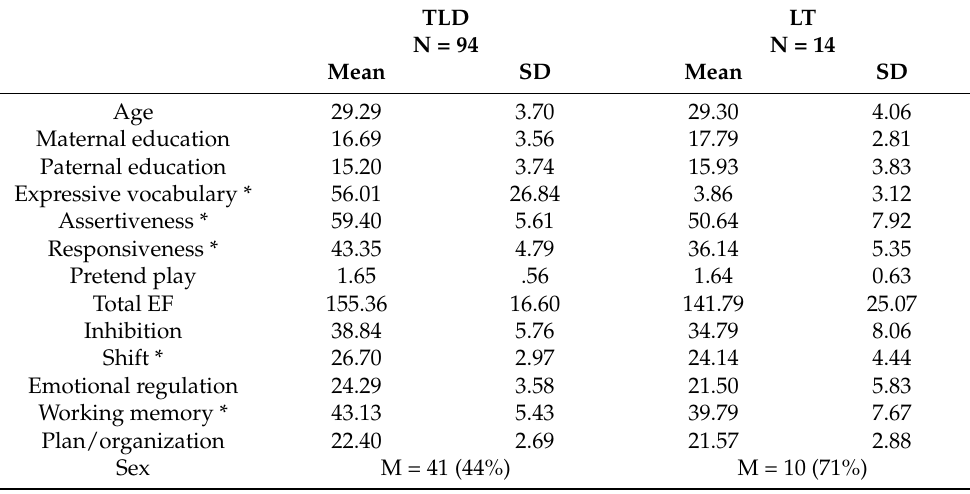
Table 2. Characteristics of the two groups of participants identified through the analysis of their expressive vocabulary. Legend: TLD—(children with) Typical Development; LT—Late Talkers; EF—Executive Functions; SD—Standard Deviation. The asterisk (*) shows when the group-related difference was